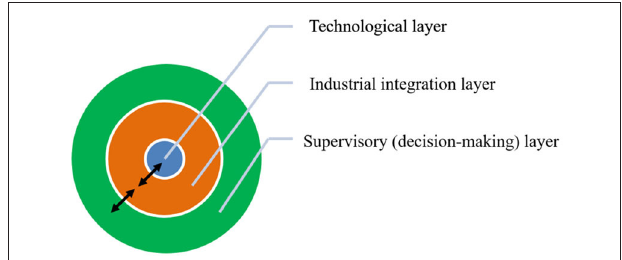
FIGURE 1 | Hierarchy of the technological, industrial integration and supervisory layers of